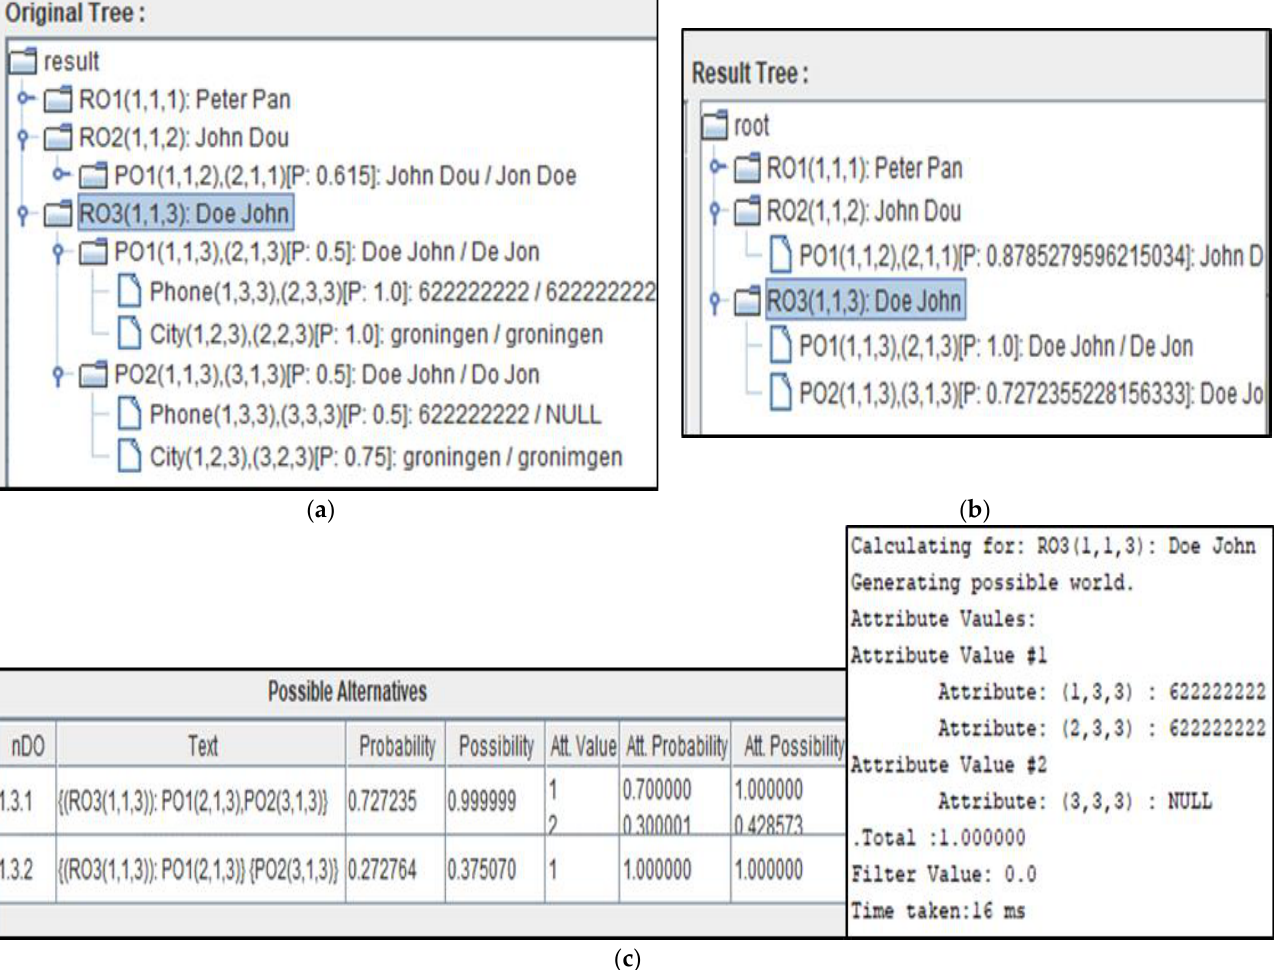
Figure 7. Phone data fusion alternatives’ example with their updated reliability score based on the C2.2.1 case. ( a ) The participated entities with their original matching tree. ( b ) The probabilistic entities linkage/merging results. ( c ) The possible data fused values for Phone attribute at each possible entities merging alternative as produced based on Figure 7b.